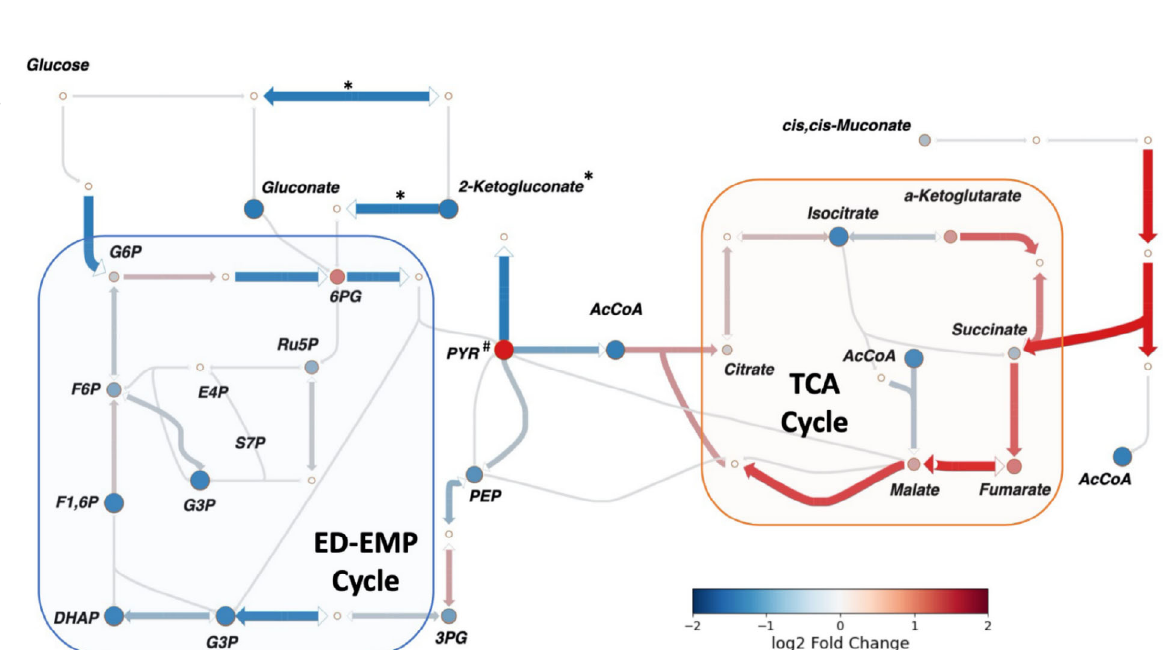
Fig. 6 | Metabolomics and proteomics pro fi ling of P. putida wild type and engineeredmuconate-catabolizing strains.a Relative and label-free intracellular metabolites levels quanti fi ed by PeakDecoder ( n =22, with 11 samples and 2 colli- sionenergiespersample).Red,yellow,and bluecolorsindicate high,medium,and low log2 intensity values, and gray color indicates missing values. b Glucose and